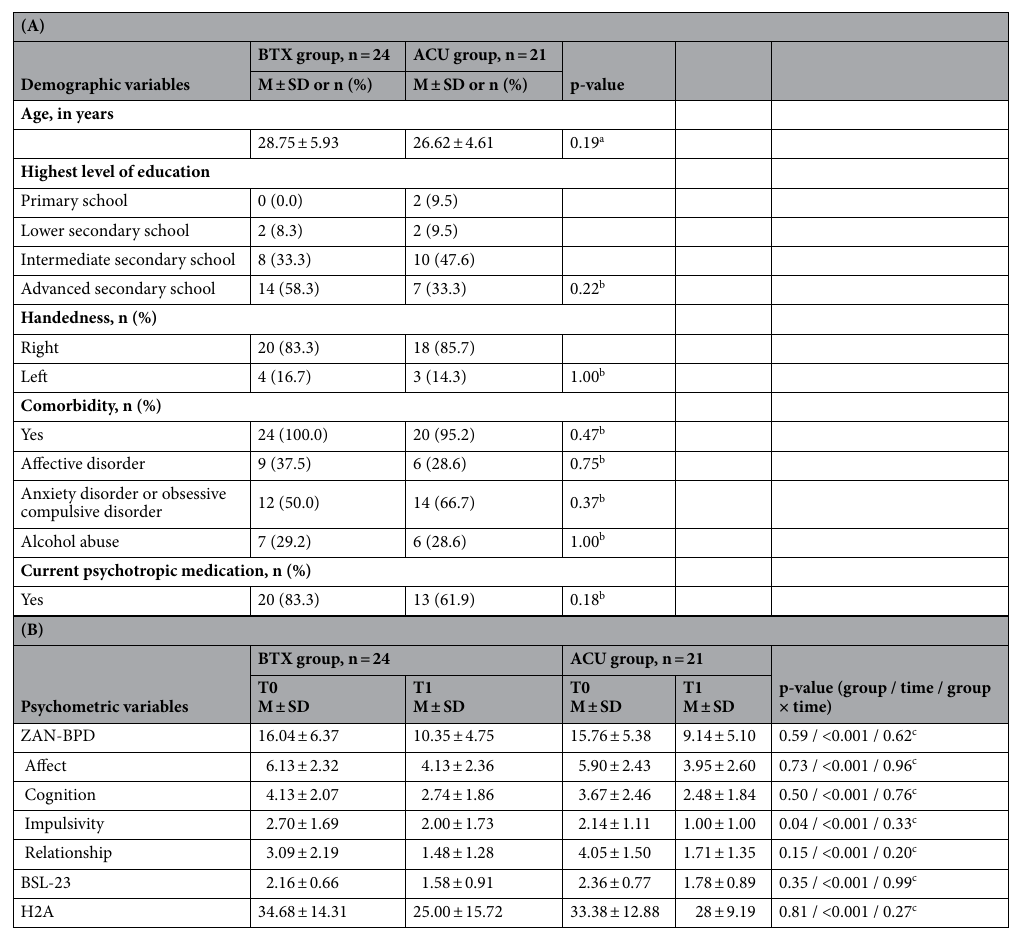
Table 1. Demographic and psychometric characteristics: (A) Demographic characteristics and the test statistics at baseline separate for BTX and ACU (total N = 45). (B) The scores of the ZAN-BPD, BSL-23 and H2A at baseline (T0) and at 4-week follow-up (T1) separate for BTX and ACU and their test statistics (total N = 45). BTX incobotulinumtoxinA, ACU acupuncture, M mean, SD standard deviation, BTX incobotulinumtoxinA, ACU acupuncture, M mean, SD standard deviation, T0 baseline, T1 4-week follow-up, ZAN-BPD Zanarini Rating Scale for Borderline Personality Disorder, BSL-23 Borderline Symptom List—23, H2A Hamburg-Hannover Agitation Scale. a statistical analysis: t -test, b statistical analysis: Fishers exact test, c statistical analysis: repeated measures analysis of